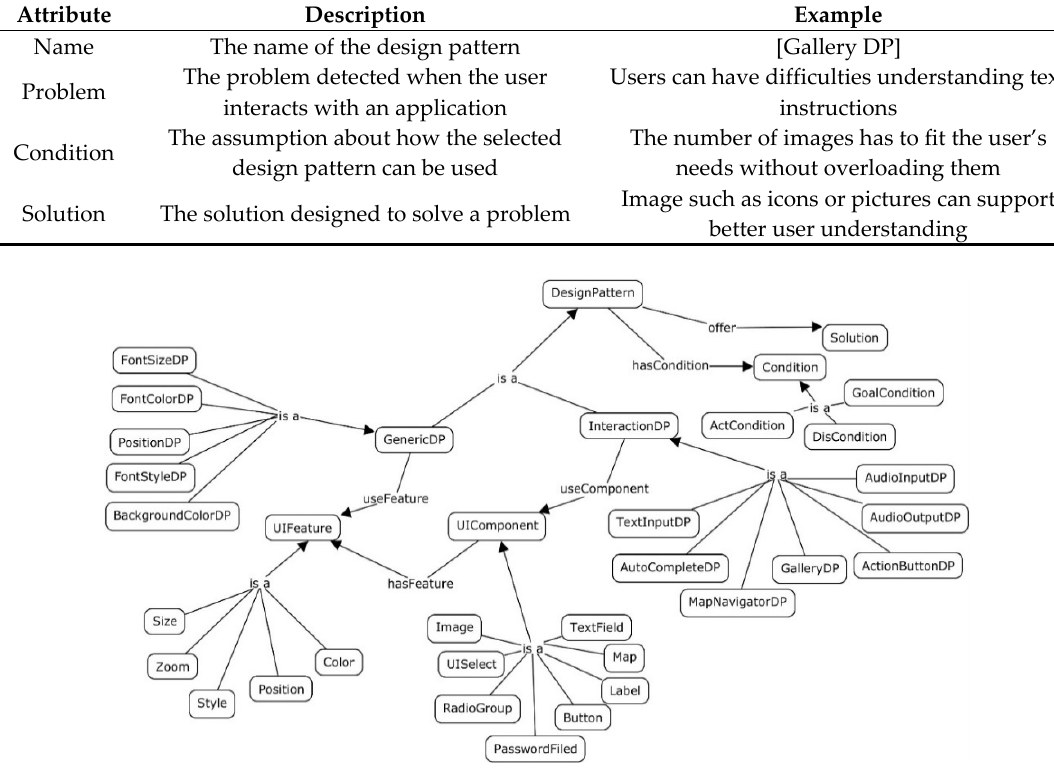
Table 1. UI design pattern structures.